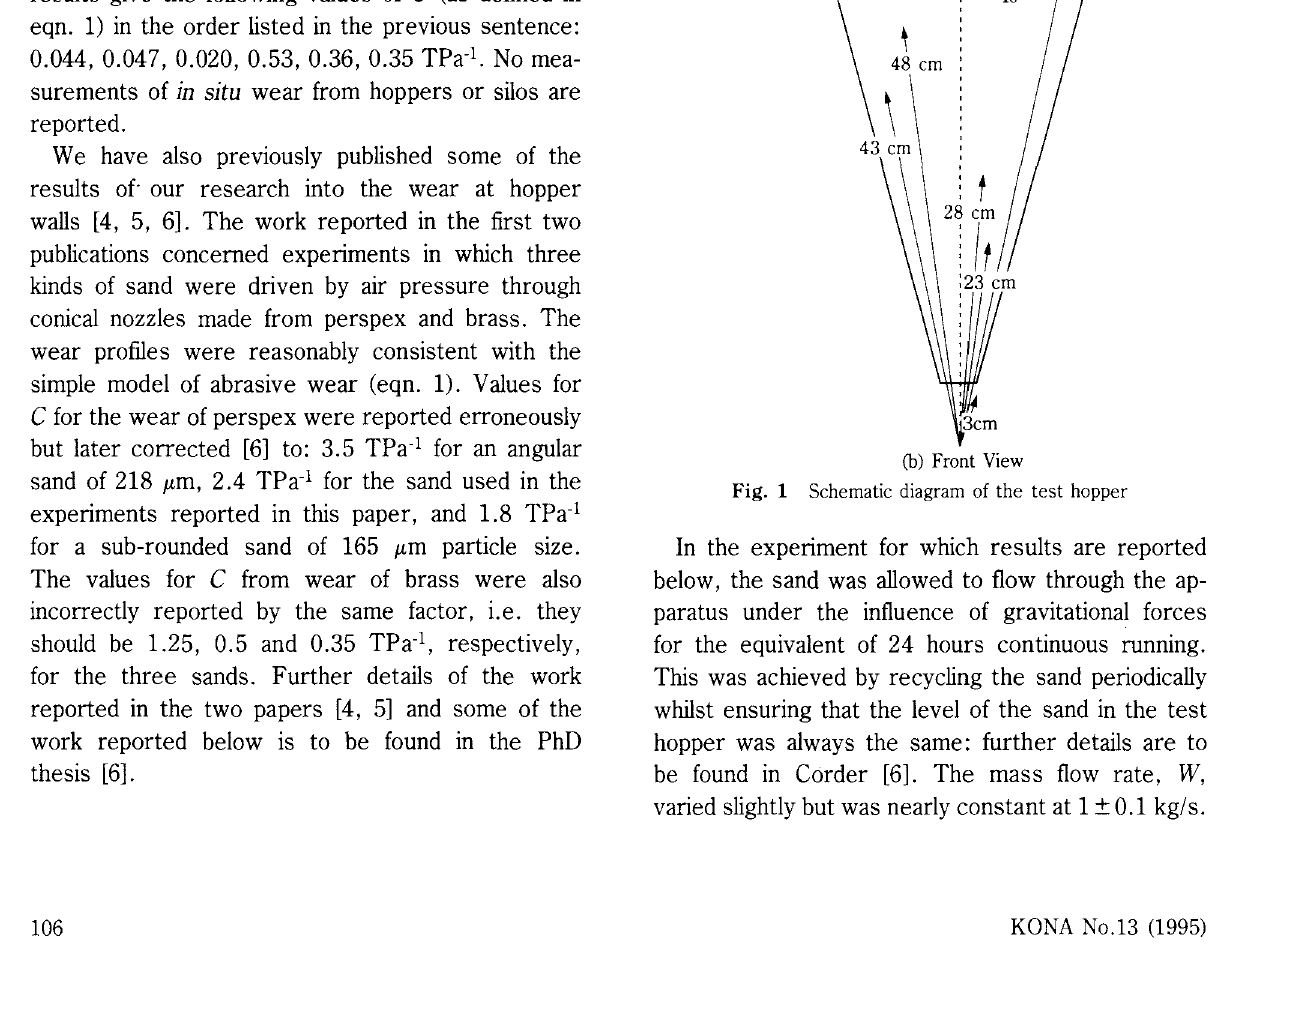
hopper was always the same: further details are to be found in Corder [6]. The mass flow rate, W, varied slightly but was nearly constant at 1 ± 0.1